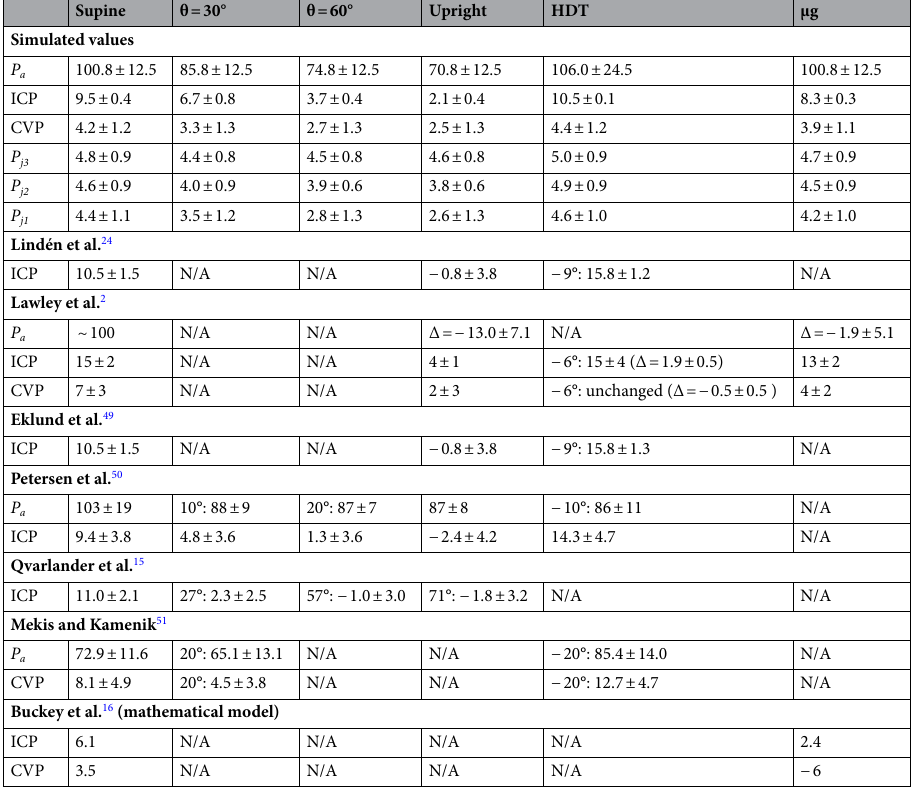
Table 1. Simulated mean pressure and literature pressure values (mean ± standard deviation) considered in this study. All values are reported in mmHg. We refer to pressure gradient ∆ when absolute values are not reported by cited authors. θ tilt angle, HDT head-down tilt, μg microgravity, P a arterial pressure, ICP intracranial pressure, CVP central venous